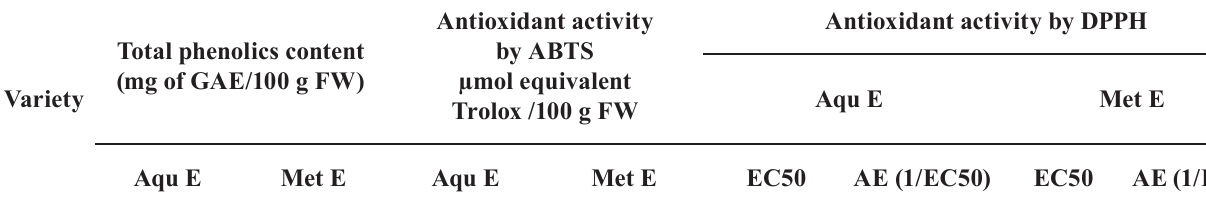
TABLE VI - Total phenolic content and antioxidant activity of date palm fruit varieties at the Tamar stage, grown in Tunisia